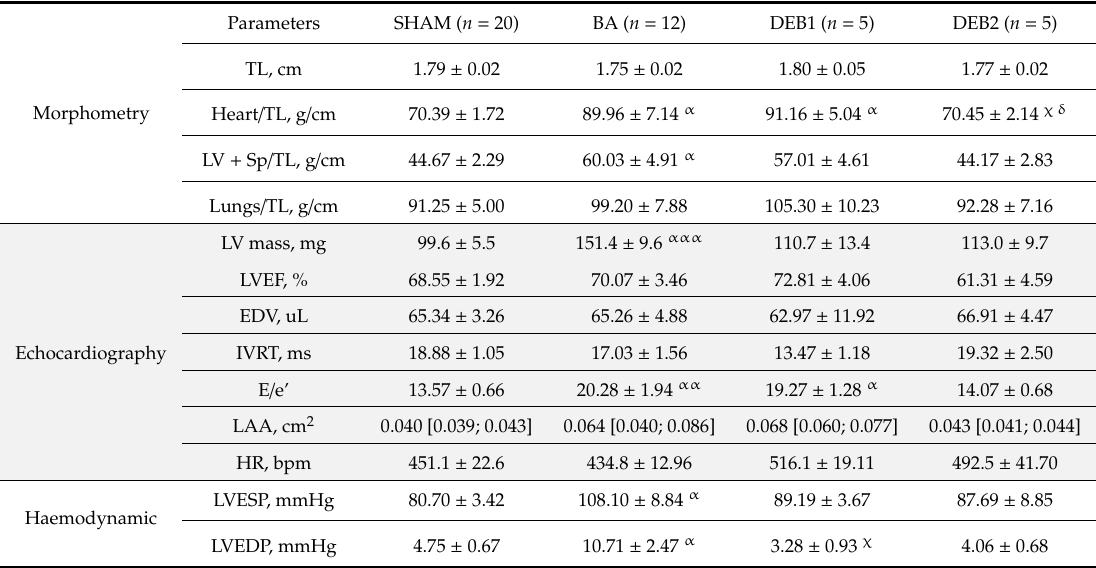
Table 1. Terminal echocardiographic, hemodynamic, and morphometric data for SHAM, BA, DEB1, and DEB2